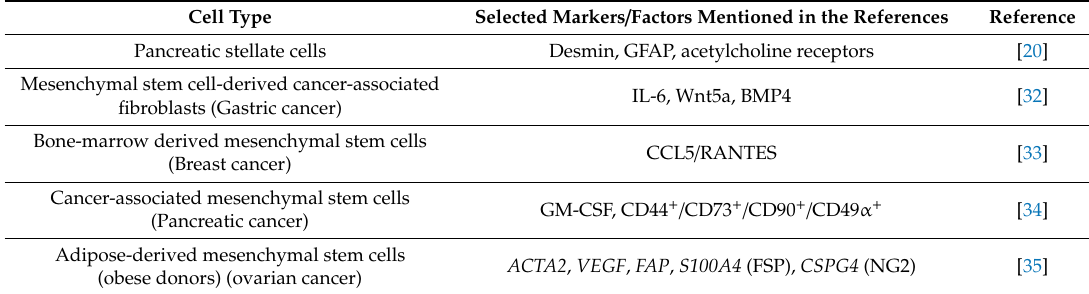
Table 2. Soluble factors and function.